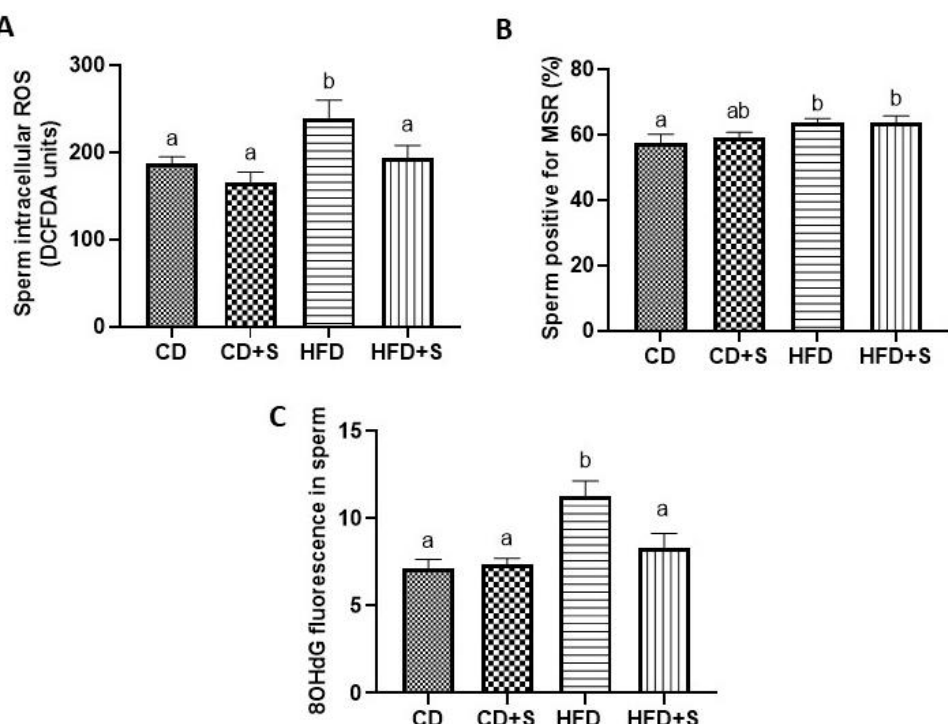
Figure 3. The e ff ect of diet and short-term micronutrient supplementation on sperm ROS concentrations and oxidative DNA damage (8OHdG). ( A ) Sperm intracellular ROS concentrations (DCFDA), ( B ) sperm superoxide concentrations (MSR), and ( C ) sperm oxidative DNA damage (8OHdG). Data is expressed as mean ± SEM. n = 12 males per diet group. CD: control diet, CD + S: control diet plus micronutrient supplementation, HFD: high fat diet, HFD + S: high fat diet plus micronutrient supplementation. Data was analyzed by a one way ANOVA. Different letters denote significantly distinct groups at p < 0.05.